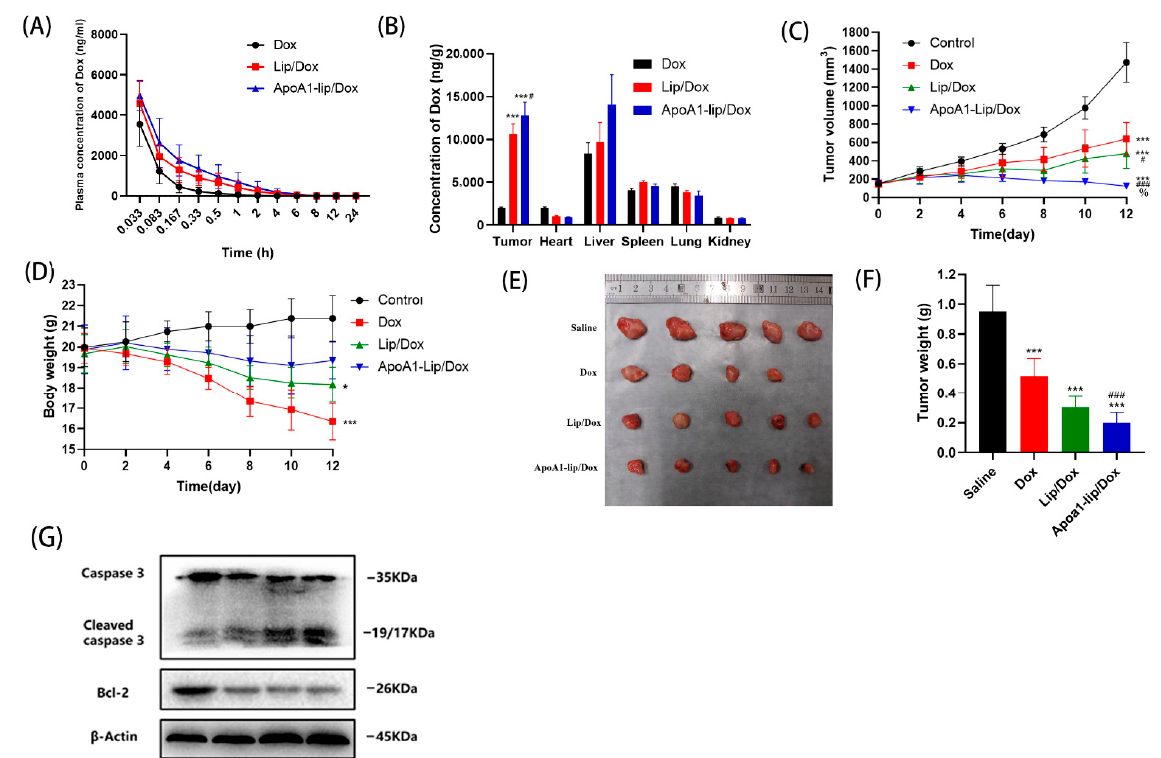
Figure 5. ( A ) Plasma concentration-time curves of Dox in rats after intravenous administration with different Dox formulations at a dose of 5 mg/kg Dox ( n = 4, mean ± SD). ( B ) In vivo biodistribution of Dox in 4T1 tumor-bearing mice at 2 h after intravenous administration with Dox, Lip/Dox, and ApoA1-lip/Dox. Data in the graph are presented as mean ± SD ( n = 4). *** p < 0.01 versus Dox group; # p < 0.05 versus Lip/Dox group. ( C , D ) The tumor volume and body weight of tumor bearing mice were measured every two days after being treated with different formulations at a dose of 5 mg Dox/kg. * p < 0.05, *** p < 0.01 compared with control, # p < 0.05, ### p < 0.01, compared with Dox group, % p < 0.05 compared with Lip/Dox group. ( E , F ) A representative photograph and average weight of removed tumor from the sacrificed mice at the end of the experiment. ( G ) The levels of apoptotic related proteins in tumor after treatment with different formulations.